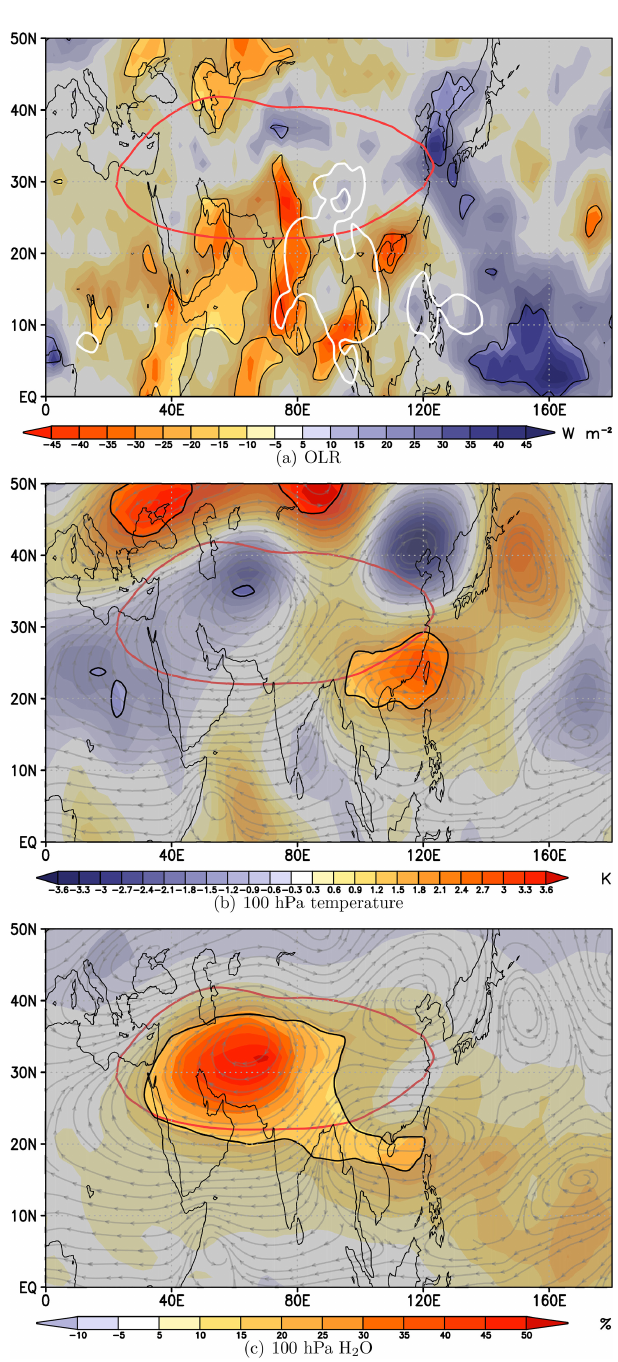
Figure 7. Regression coefficients from MLR for the MIDX of JA average data, with (a) NOAA OLR, (b) ERA-Interim 100hPa tem- perature, and (c) ERA-Interim 100hPa H 2 O. The 205Wm − 2 con- tour line of NOAA OLR is plotted in white on panel (a) . Red con- tours of the 16750m geopotential height at 100hPa mark the posi- tion of the AMA. Grey streamlines on panels (b) and (c) mark the horizontal wind components, regressed on the MIDX. Overlaid grey shading indicates regions where the regression is not significant at the 95%